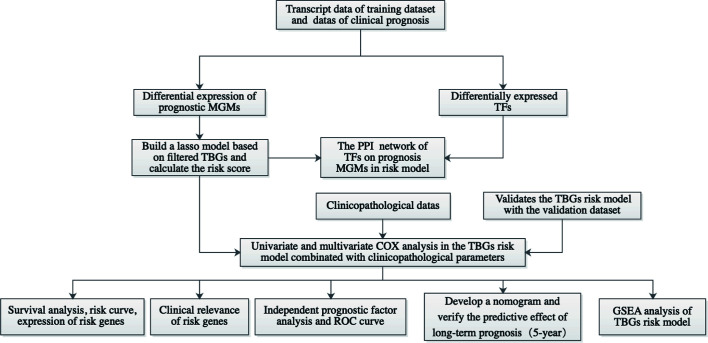
Workflow graph for this study. MGMs, marker genes of macrophage; TBGs, TAM-based ten-gene signatures; TFs, transcription factors; PPI, protein–protein interaction; ROC, receiver operating characteristic; GSEA, gene set enrichment analysis.